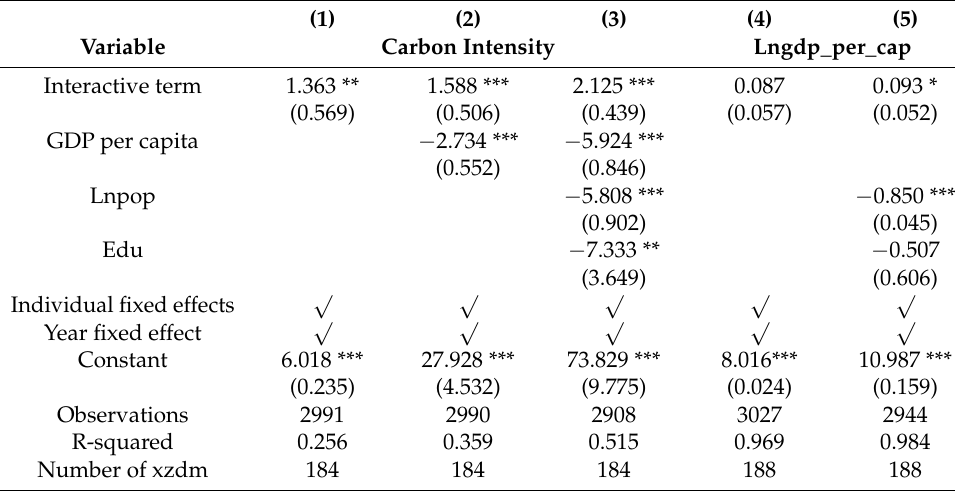
Table 7. Tests for changing the observation